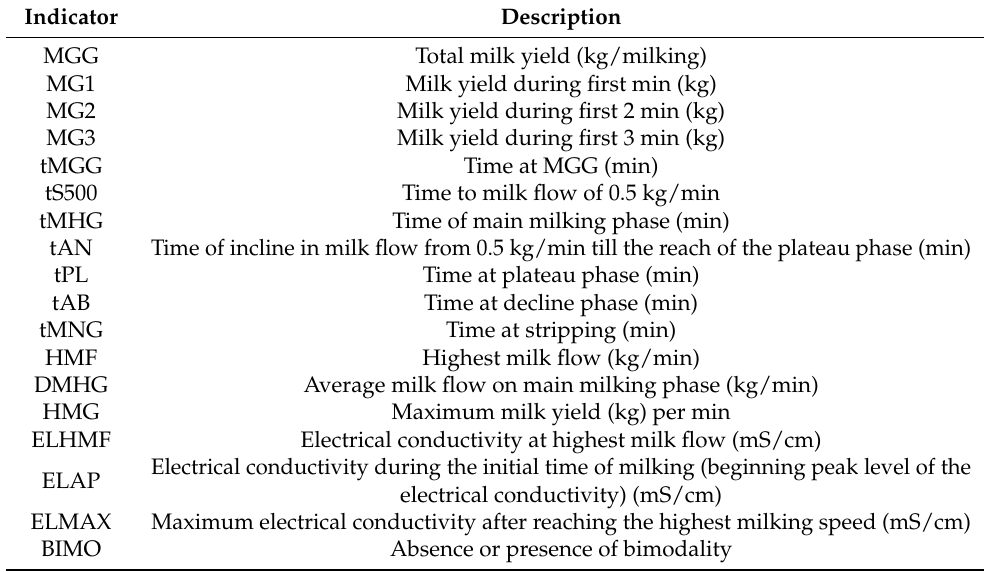
Table 1. Description of evaluated traits with Lactocorder ®®